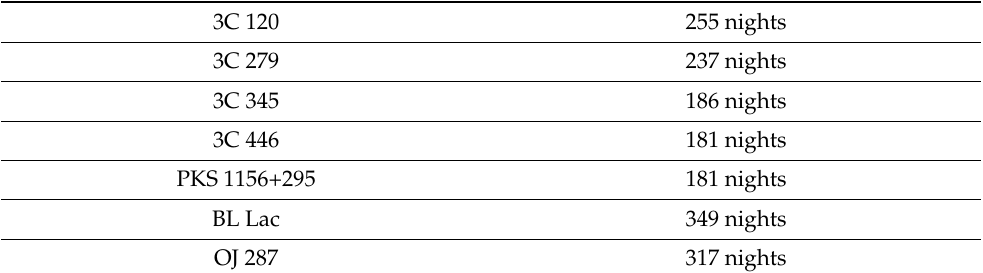
Table 1. Sample of RHO most observed